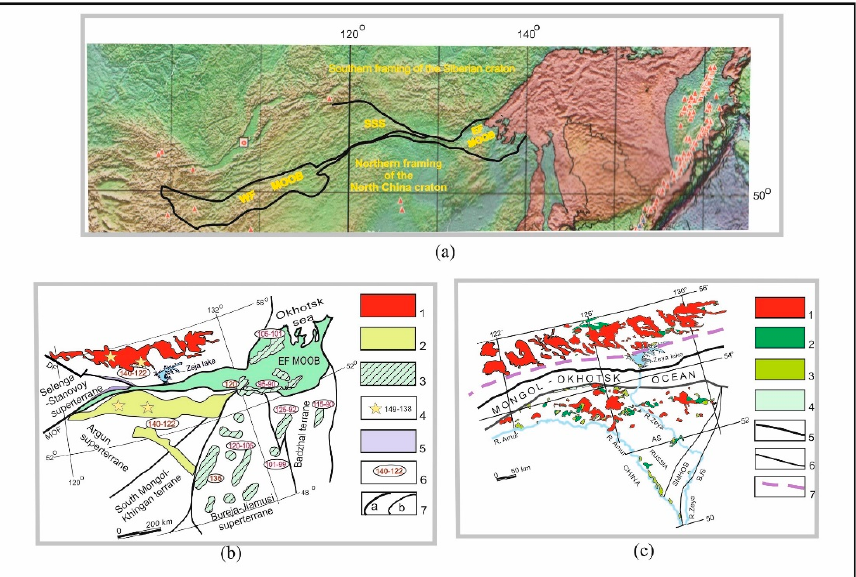
Figure 1. Scheme of the spatial position of the EF MOOB and magmatic complexes in its frame. ( a ) The position of the MOOB among the regional structures of eastern Asia on the Geological map of the world scale 1:50,000,000 [17]. ( b ) Scheme of the modern tectonic zoning of the EF MOOB, its framing and the location of the Late Mesozoic magmatic complexes [3], author’s data. The rocks of the suprasubduction (149–122 Ma) and bimodal (119–97 Ma) complexes of the Early Cretaceous in the frame of the EF MOOB (1–2): plutonic ones predominate (1); predominantly volcano-plutonic (2). Late Mesozoic igneous complexes of the eastern end of the MOOB, the Bureya-Jiamusa superterrane, and the Badzhal terrane (3). The area of distribution of adakite granites (4). Melange zones formed in KZ by [5,18] (5). Time of formation of igneous rocks (6). Tectonic boundaries: (a) regional structures; (b) others (6). Fault zone: Dzheltulak (DF), Mongol-Okhotsk (MOF). ( c ) Scheme of Late Mesozoic tectonic zoning and the location of magmatic formations in its frame before tectonic restructuring in the Cenozoic [5,18]. Igneous rocks (1–3): Late Mesozoic granitoids (149–97 Ma) (1); calc-alkaline volcanic (128–122 Ma) (2); volcanic rocks of the bimodal series (119–97 Ma) (3); trachyandesites, absarokites of rifting (94–88 Ma) (4). Conditional boundary of MOB (5). Structural tectonic boundaries (6). The boundary of the distribution of Late Mesozoic magmatic complexes before tectonic restructuring in the Cenozoic [5] (7). Abbreviation: superterranes-Bureya-Jiamusi (BJS), Argun (AS); South Mongolian-Khingan Orogenic Belt (SMHOB)